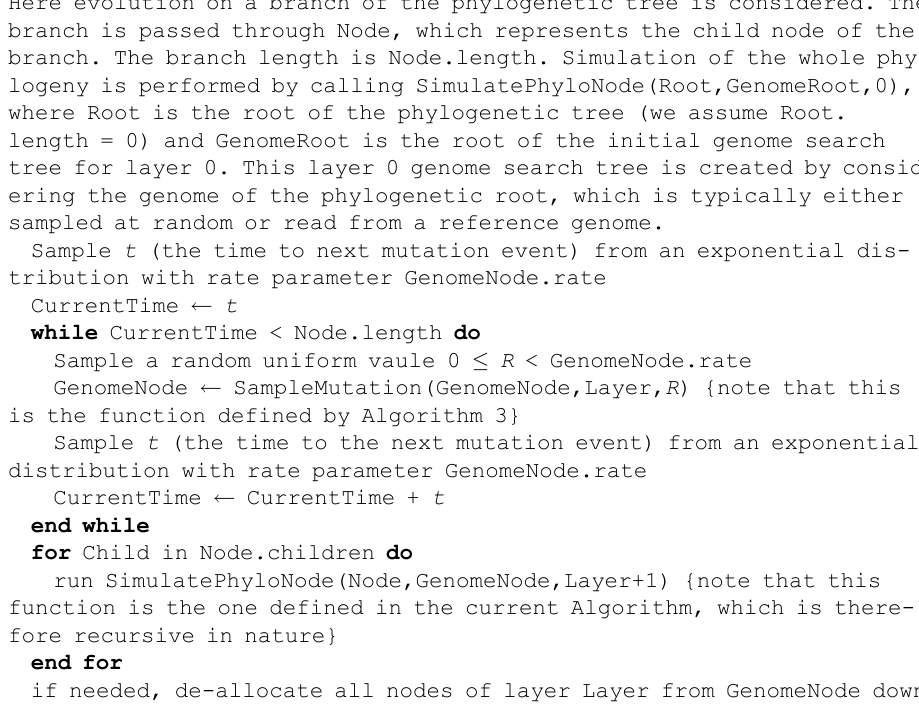
Algorithm 4 SimulatePhyloNode(Node,GenomeNode,Layer): Hierarchical algorithm for simulating sequence evolution along a branch of the phylogenetic